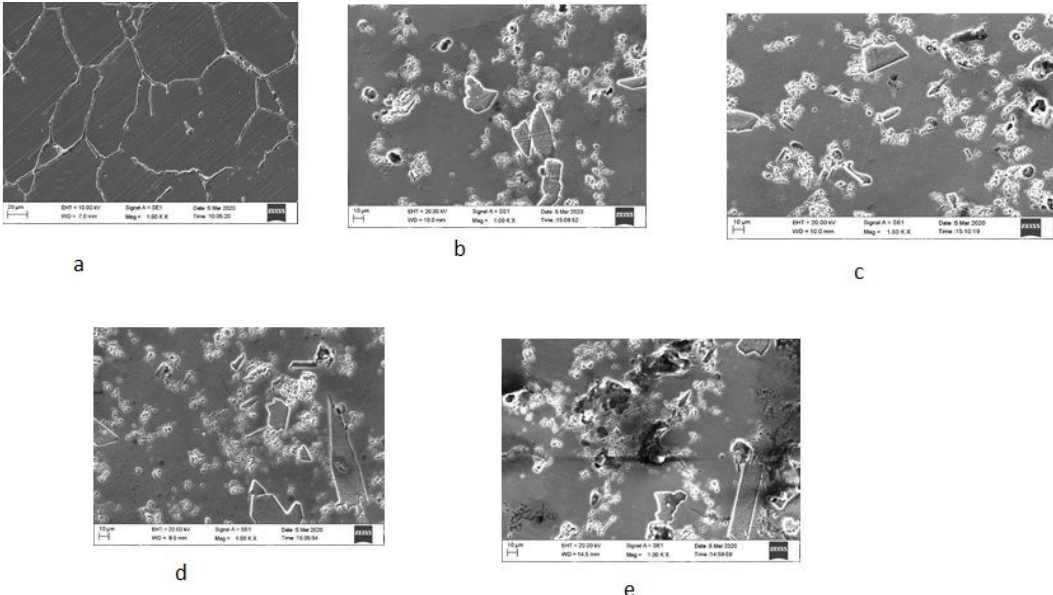
Figure 4. Microstructure of as cast Al 7075 alloy and composites in etched condition a) 2 wt% steel powder b) 4 wt% steel powder c) 6 wt% steel powder d) 8 wt% steel powder e) 8 wt% steel